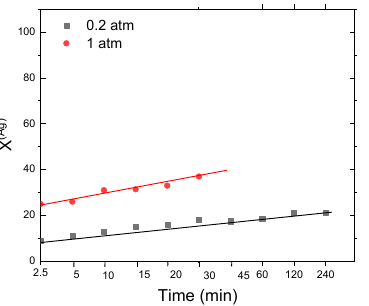
Figure 9. Leaching of Ag from MW: Effect of O 2 partial pressure.